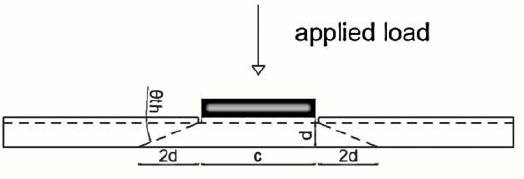
Figure 15. Cracking mode section. Table 17. Punching shear average value and standard deviation.